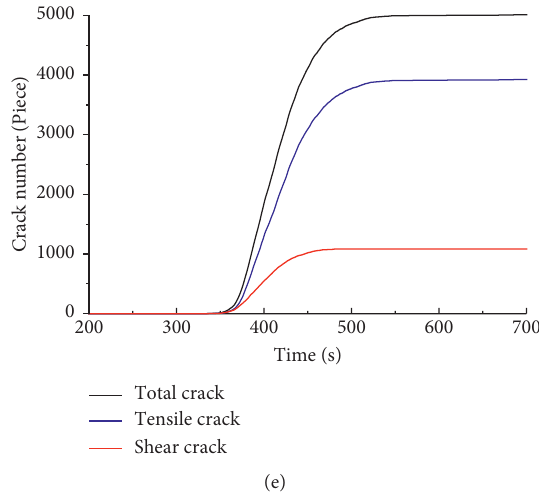
Figure 5: Crack evolution characteristics: (a) α � 0 ° ; (b) α � 30 ° ; (c) α � 45 ° ; (d) α � 60 ° ; (e) α � 90 ° .